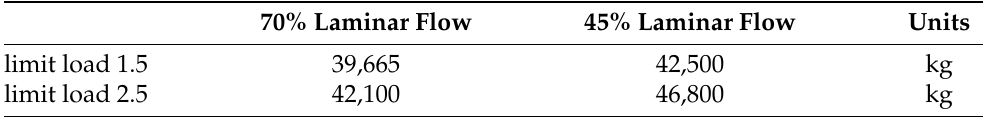
Table 10. MTOM values for the airframe weight reduction of 0%.